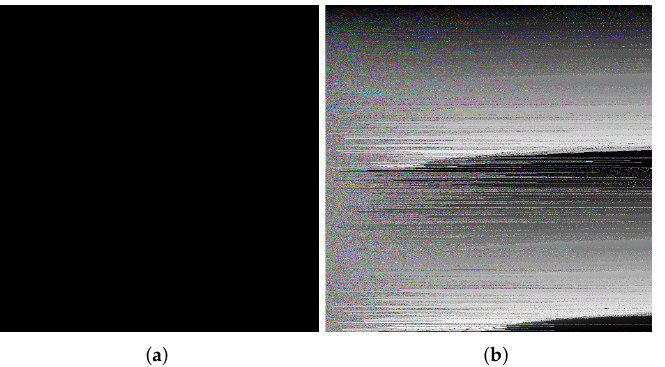
Figure 7. The result of the first version of the deterministic noise. ( a ) Black image. ( b ) Deterministic noise added to ( a ).